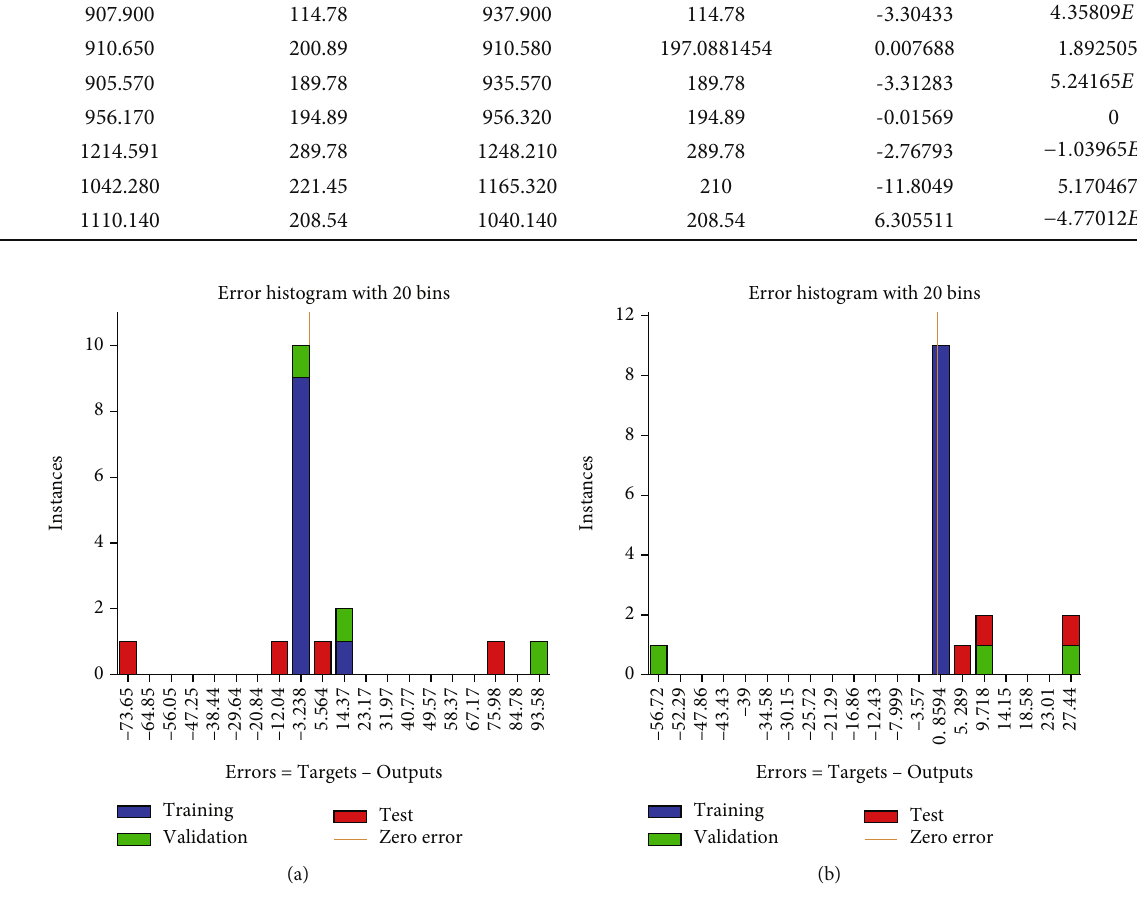
Figure 6: Error plots of (a) iodine and (b) methylene